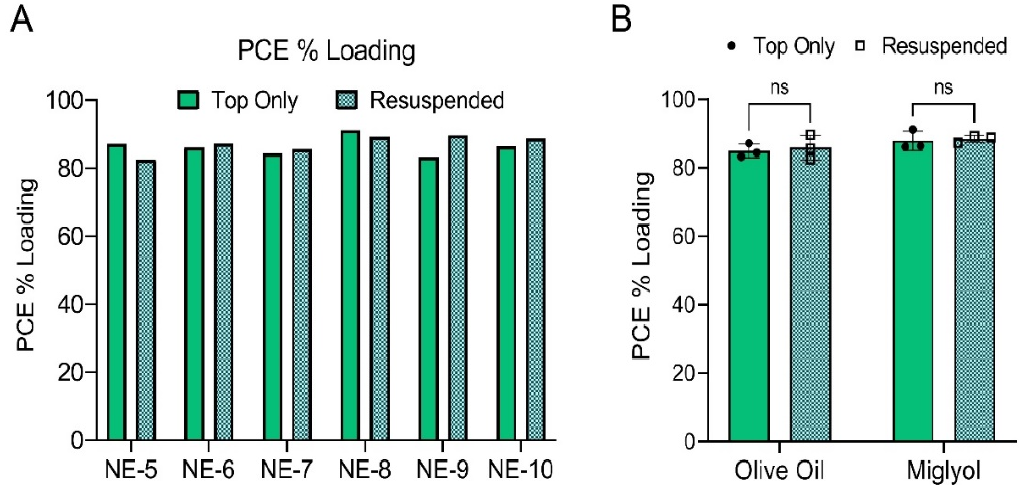
Figure 8. Nanoemulsion PCE loading for stage 2 nanoemulsions. Nanoemulsions were stored undisturbed for 20 days, after which PCE loading was measured before (top only) and after (resuspended) nanoemulsion was thoroughly mixed. PCE loading values are shown for ( A ) each nanoemulsion individually and ( B ) as the average of three nanoemulsions grouped by hydrocarbon oil. ns, no significance.